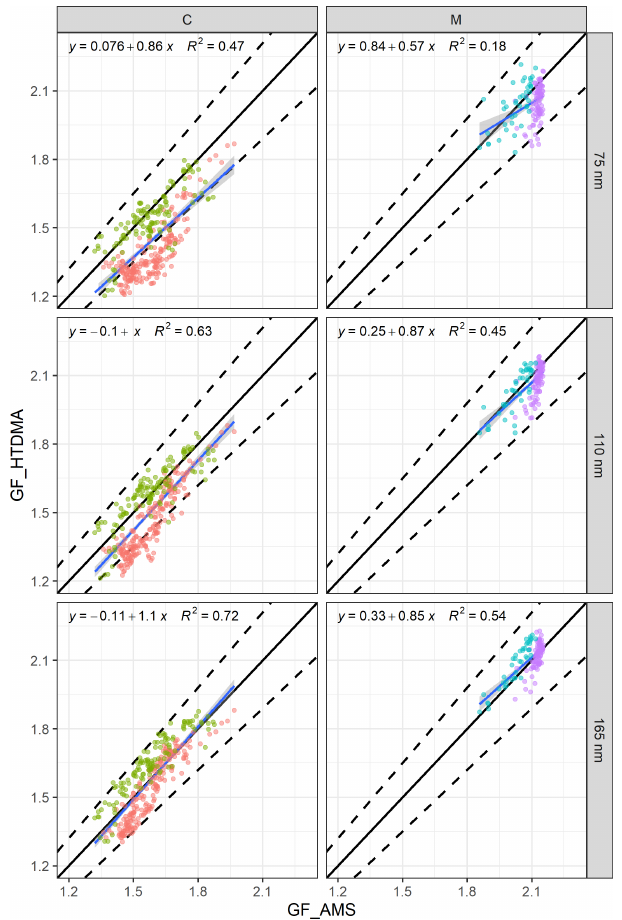
Figure 7. The relationship between GF_AMS and GF_HTDMA ( D 0 of 75, 100 and 165nm) of ( a ) continental events (C1 in red and C2 in green) and ( b ) marine events (M1 in blue and M2 in pur- ple). The black line is the 1 : 1 line for continental (C) or marine (M) events, the dashed lines are the 10% deviation and the blue line is the regression equation.